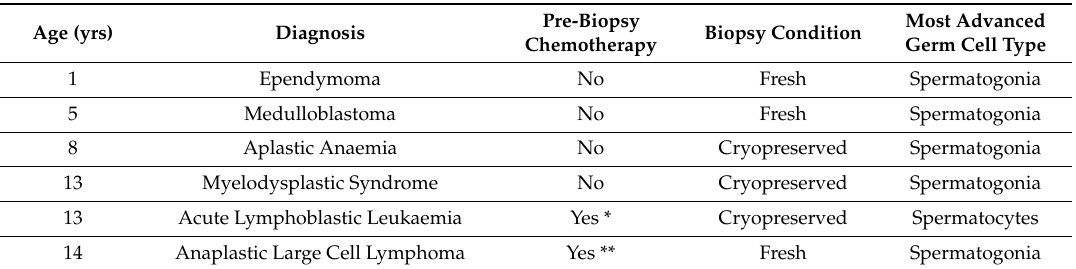
Table 1. Patient